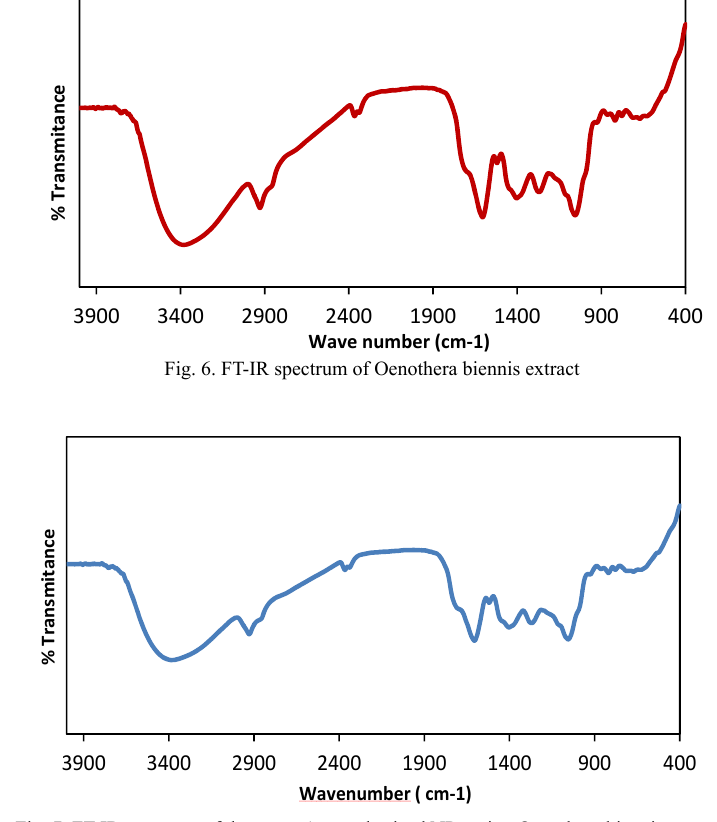
Fig. 7. FT-IR spectrum of the green Ag synthesized NPs using Oenothera biennis Fig. 7 FT-IR spectrum of the green Ag synthesized NPs using Oenothera biennis extract